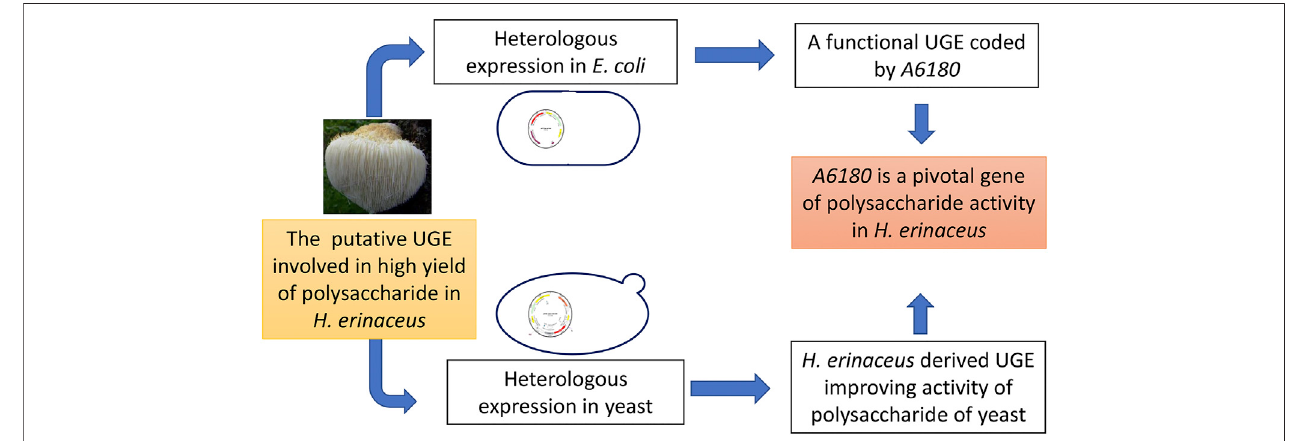
FIGURE 7 | Schematic diagram of this